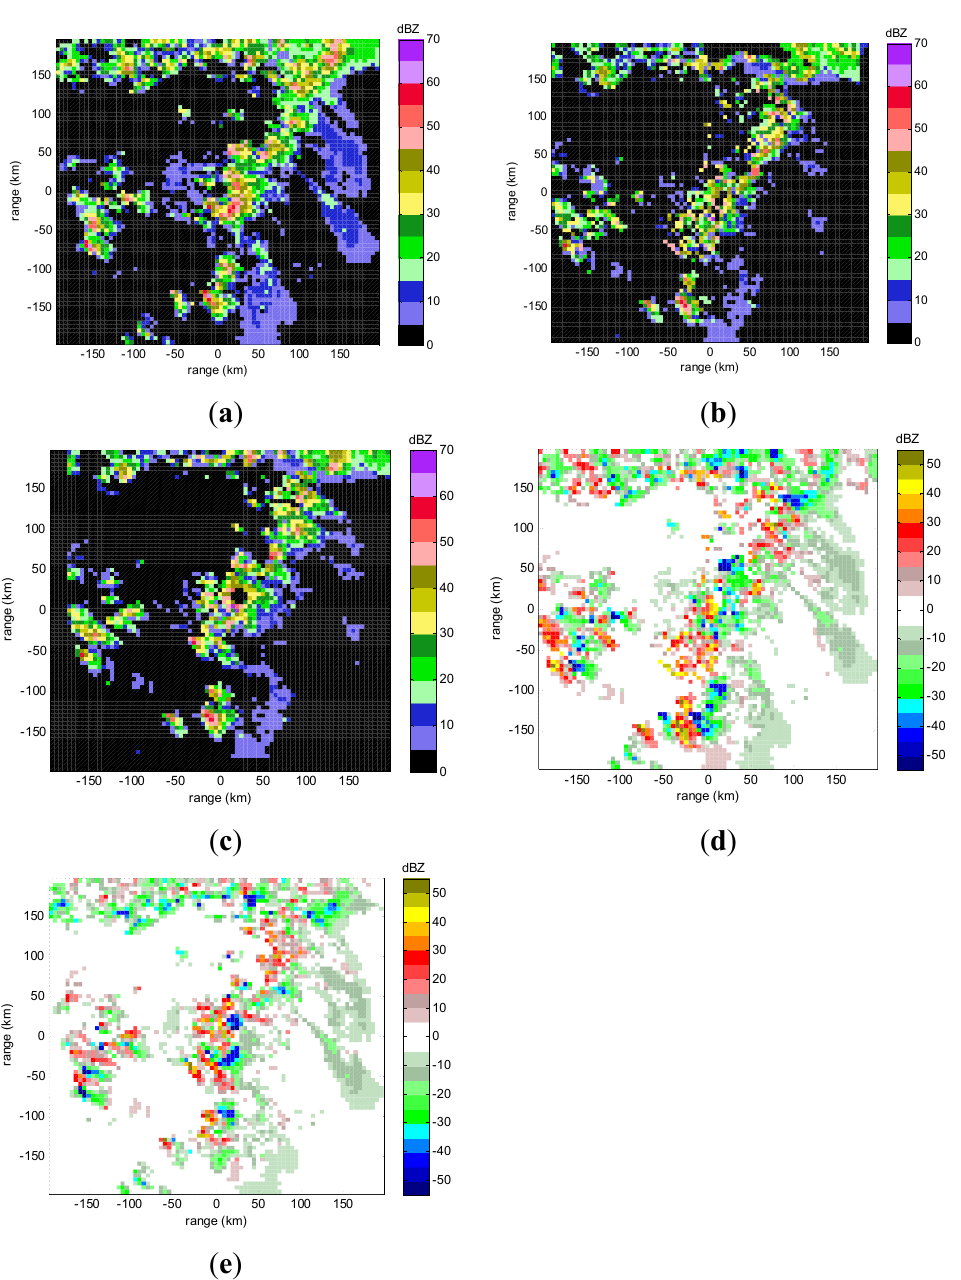
Figure 3. Radar reflectivity at 3 km height of the Changsha case at 12:56 (UTC) on 11 April 2006 with radar station at origin (0,0). ( a ) actual reflectivity; ( b ) forecasting reflectivity by COTREC; ( c ) forecasting reflectivity by GVAD; ( d ) difference between forecasting reflectivity by COTREC and actual reflectivity; ( e ) difference between forecasting reflectivity by GVAD and actual